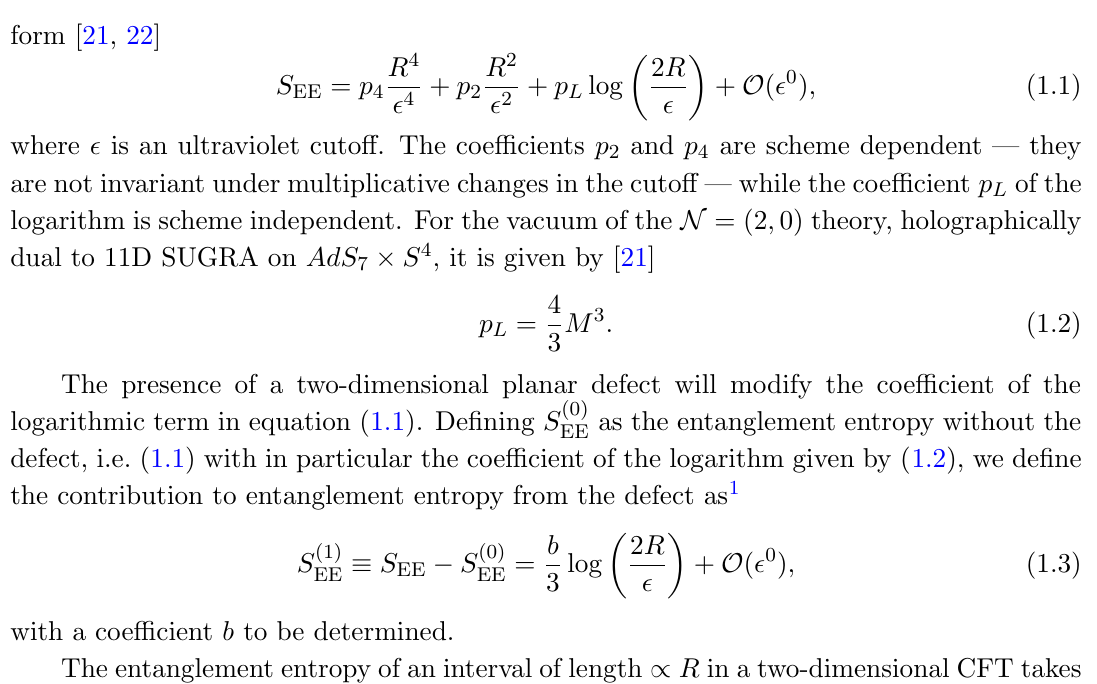
Figure 1. We compute the entanglement entropy between a spatial subregion B , and its com- plement (cid:22) B . Throughout, we will take B to be a (cid:12)ve-dimensional ball of radius R (shaded blue in the diagram), centered on a planar (1+1)-dimensional defect (the thick, vertical line, with dots indicating that the defect extends to in(cid:12)nity). The intersection of B with the defect is an interval of length 2 R , so it is not surprising that the contribution of the defect to the entanglement entropy takes the form (1.3) of the entanglement entropy for a single interval in a 2D CFT. The coordinates x and r are de(cid:12)ned in section